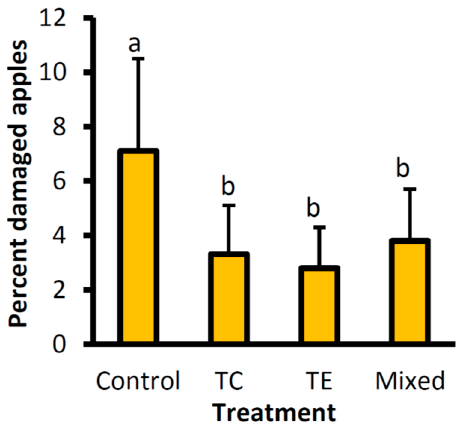
Figure 2. Average percent apples damaged by C. pomonella (±SE) in a completely randomized block experiment with four treatments; mass release using Trichocards ® of T. evanescens (Te), T. cacoeciae (Tc), a mix of the two species (Mixed) and a control for years 2012 and 2013.